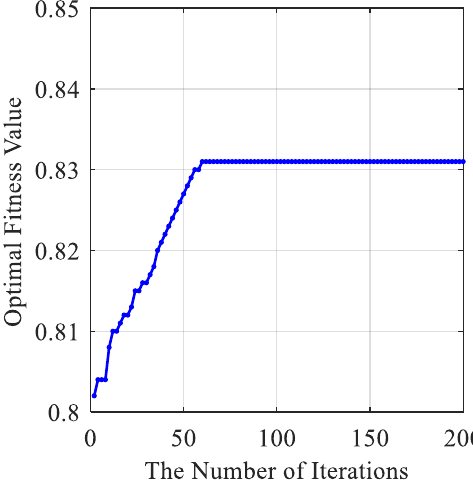
Figure 16. The global optimal solution results.